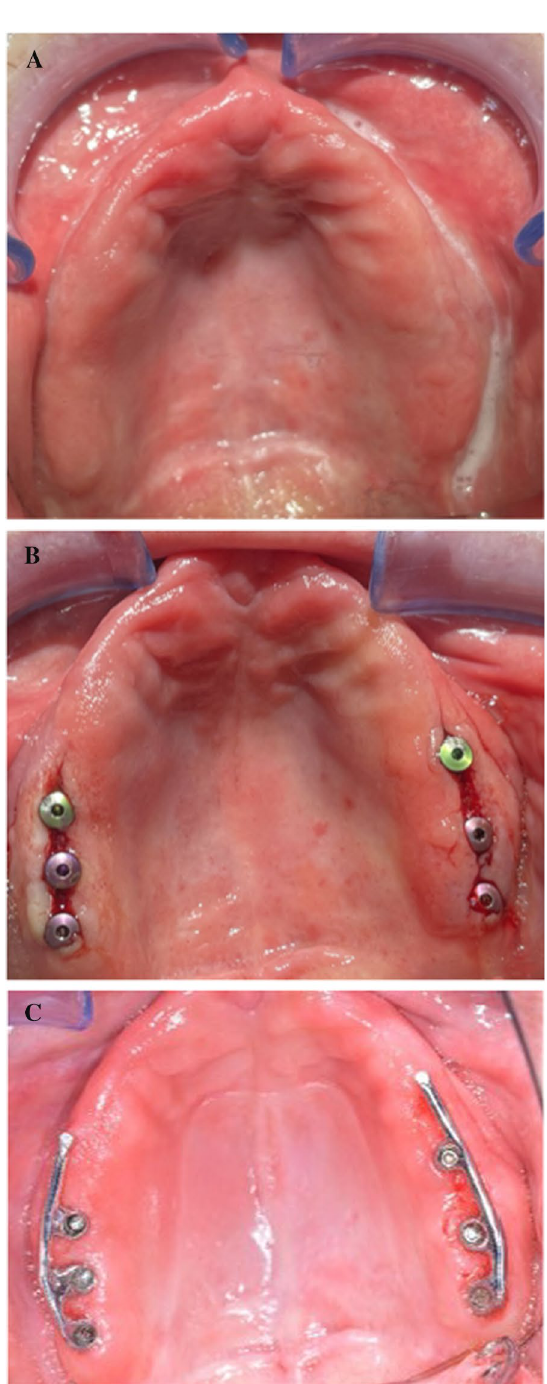
Fig. 4 Intraoral image 8 months after surgery. The patient was treated with a removable bar‑supported prosthesis. A Before exposing the implants. B After exposing the implants. C Finished bar